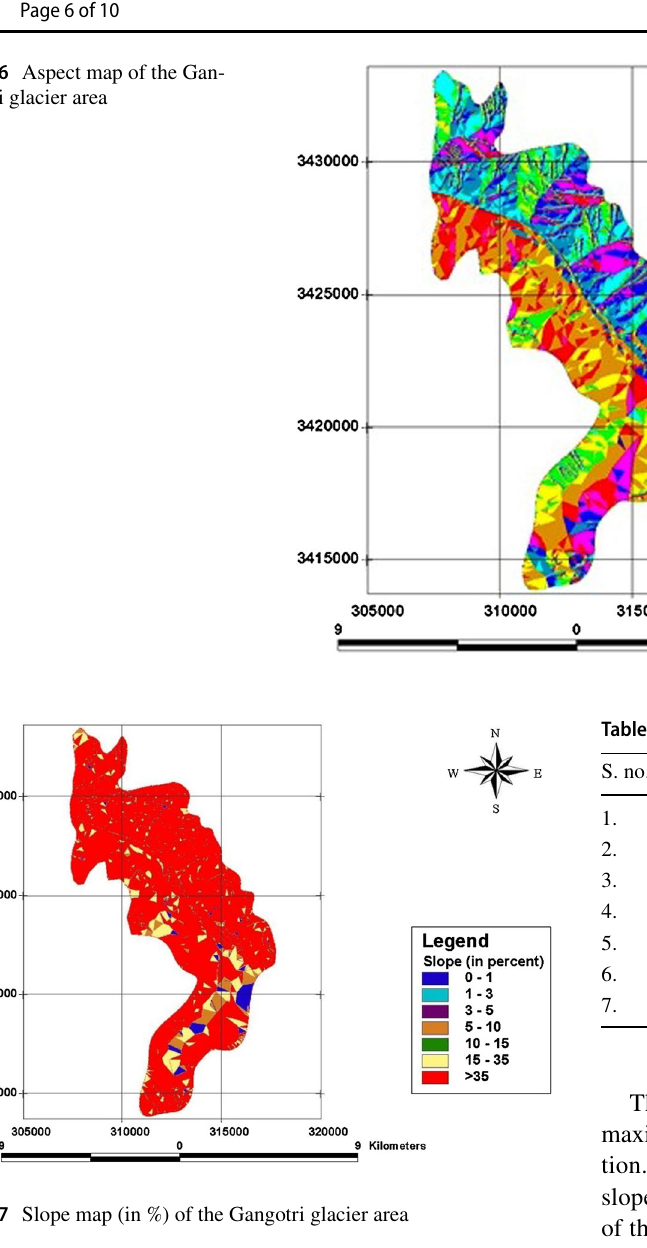
Fig. 7 Slope map (in %) of the Gangotri glacier area